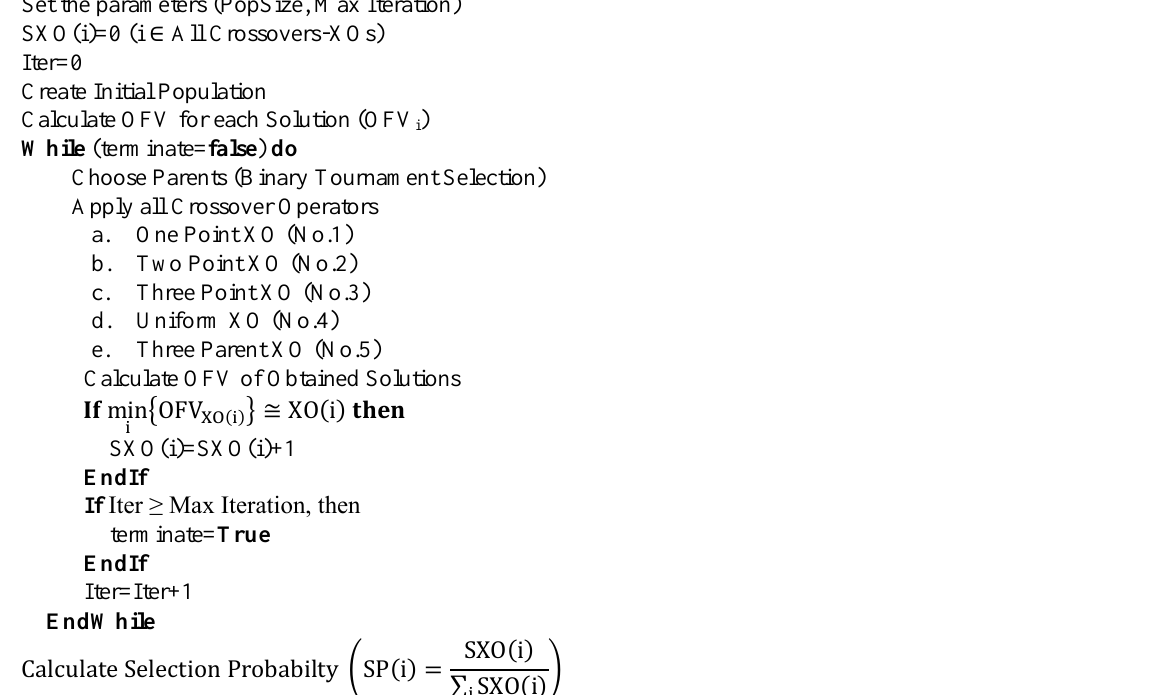
Figure 4. Pseudo code of SAICA’s initialization